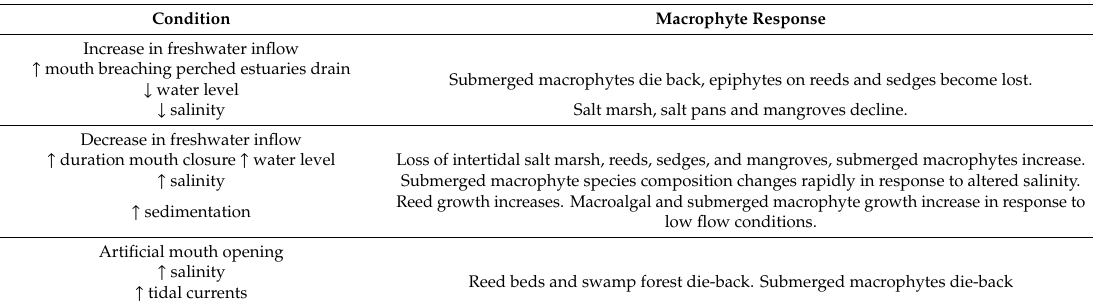
Table 2. Response of macrophytes in TCEs to changes in environmental